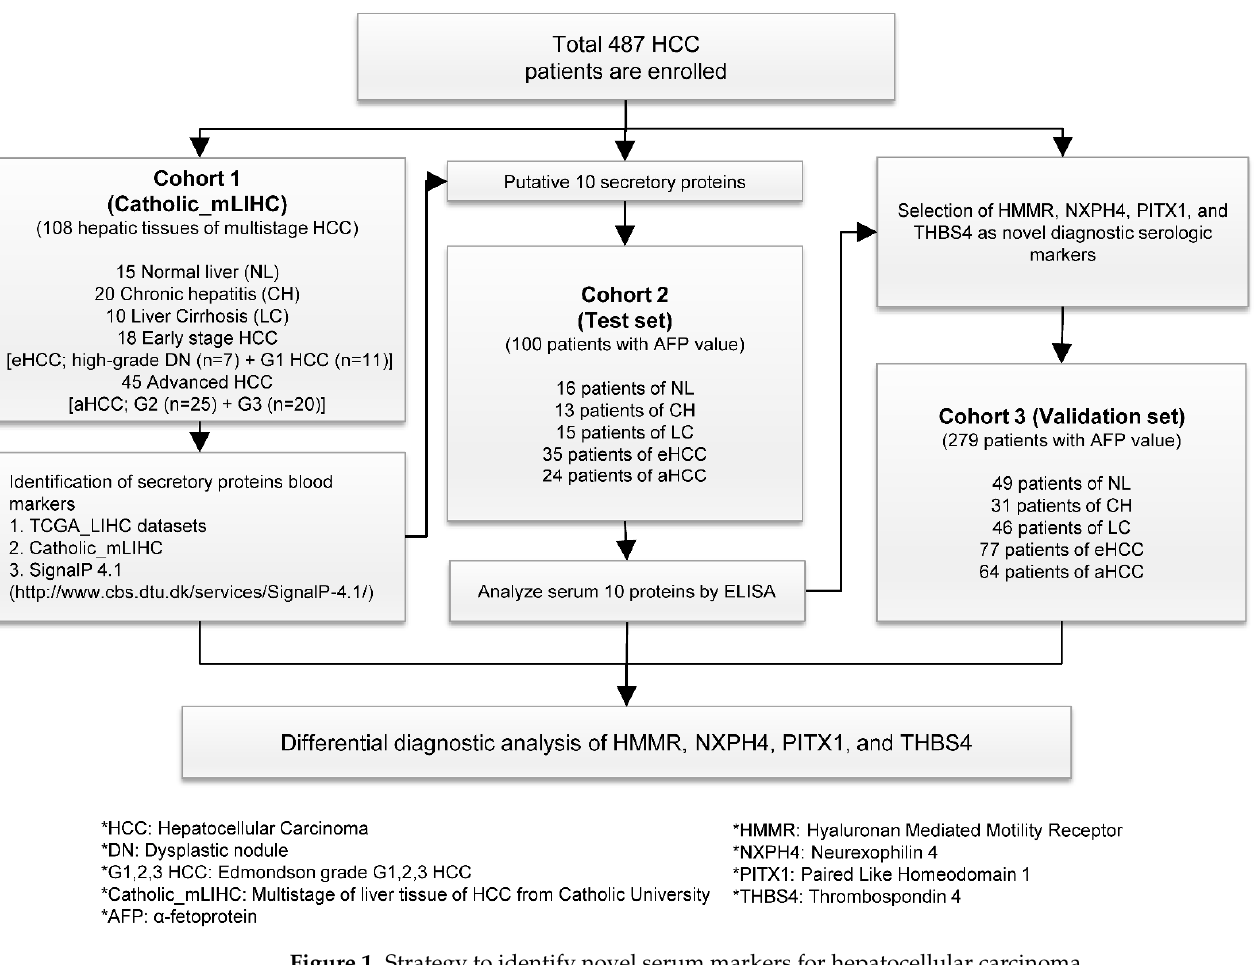
Figure 1. Strategy to identify novel serum markers for hepatocellular